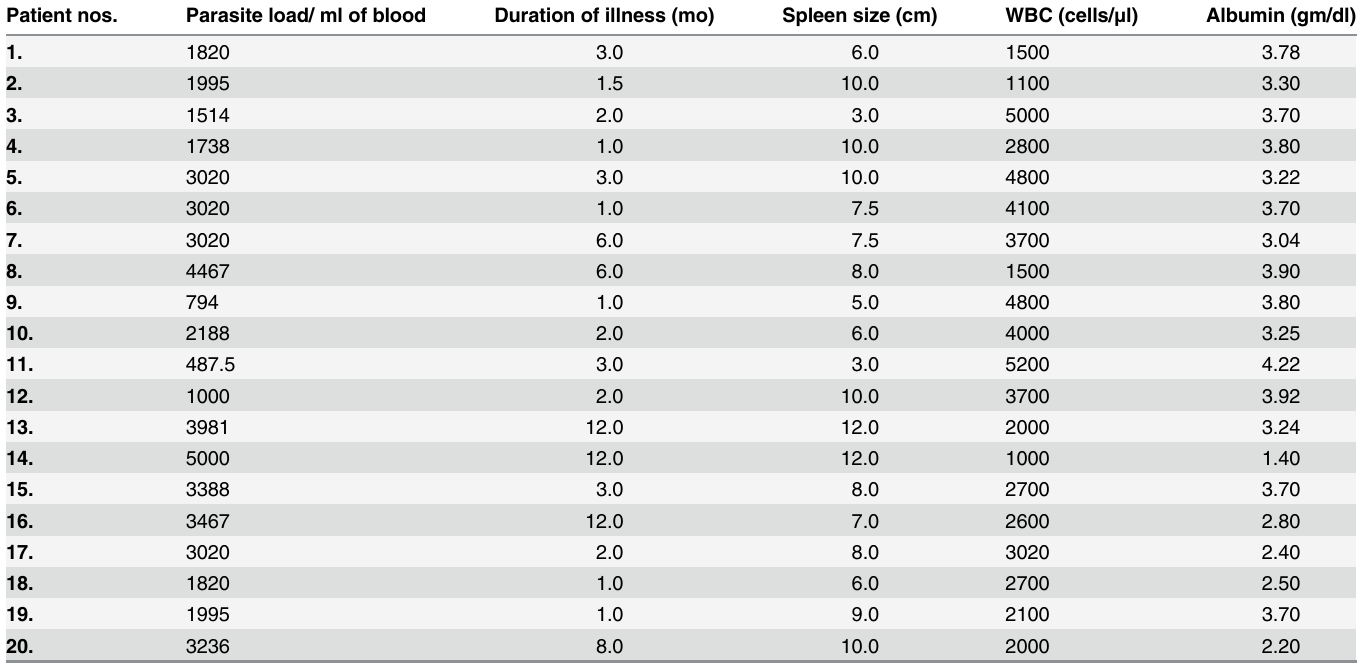
Table 2. Results of Leishmania DNA quantification in blood samples and clinical parameters of VL patients. Patient